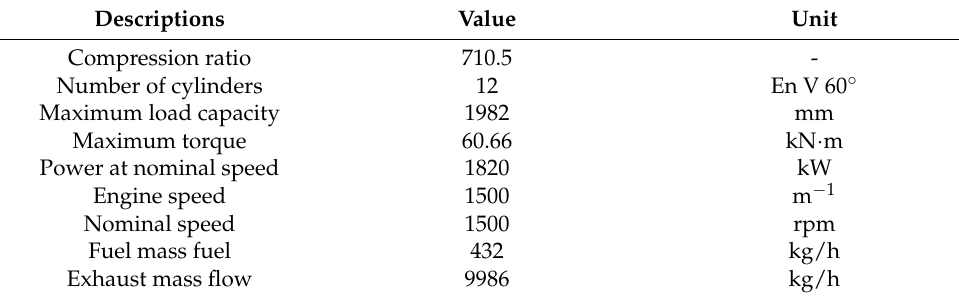
Table 1. Main engine characteristics.